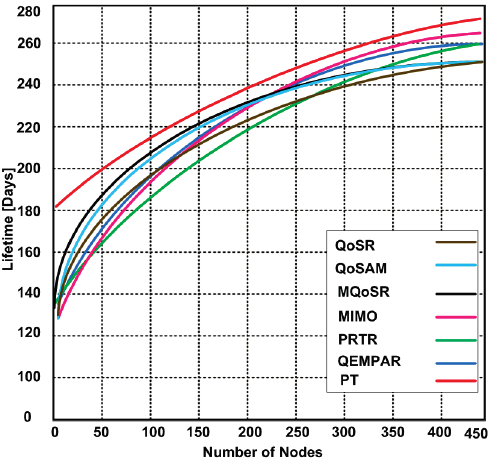
Figure 9. Network lifetime using different routing protocols and network